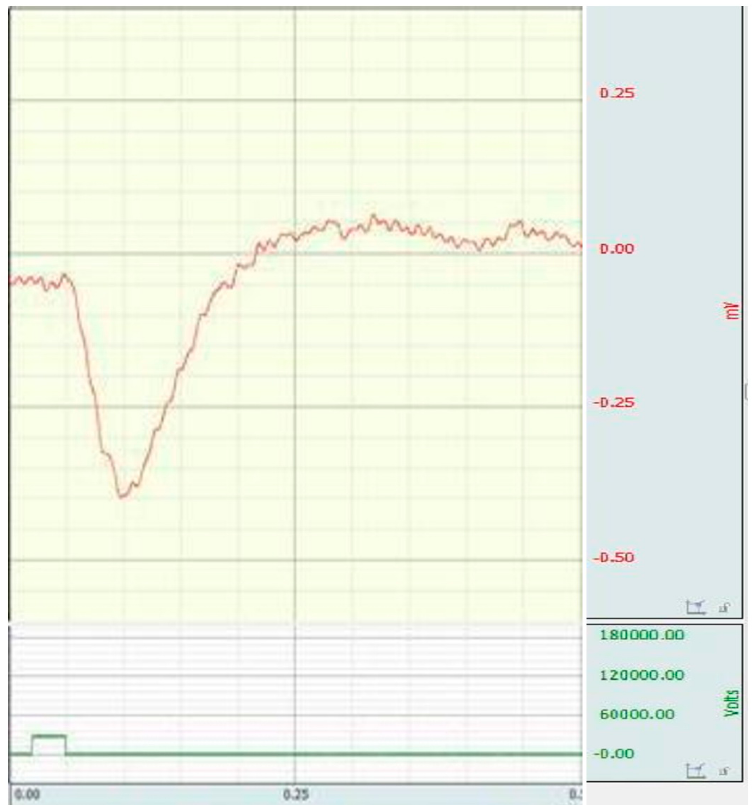
Figure 2. Electroretinogram of rat with the simulated retinal ischemia-reperfusion (inhibition of b-wave is observed).